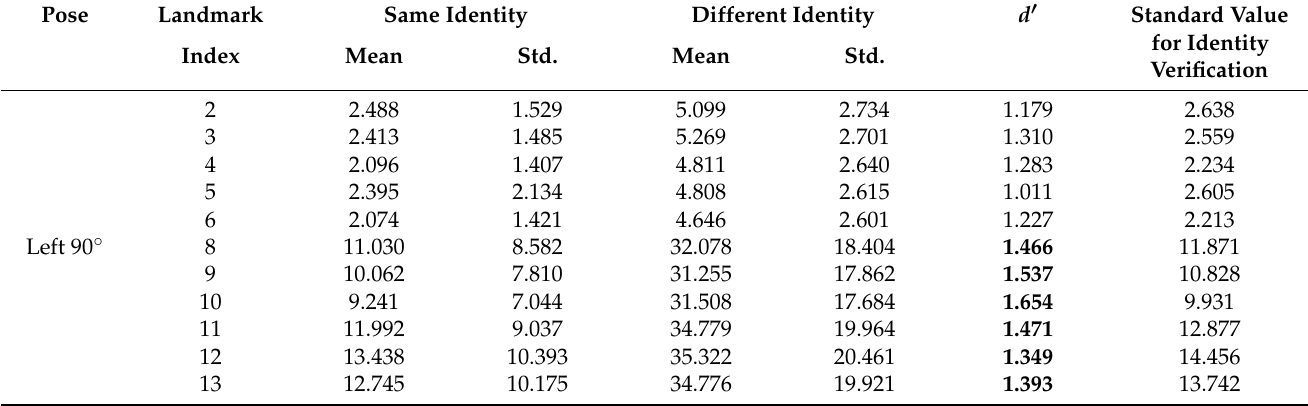
Table 3. Mean and Standard deviation of ED between each reciprocal